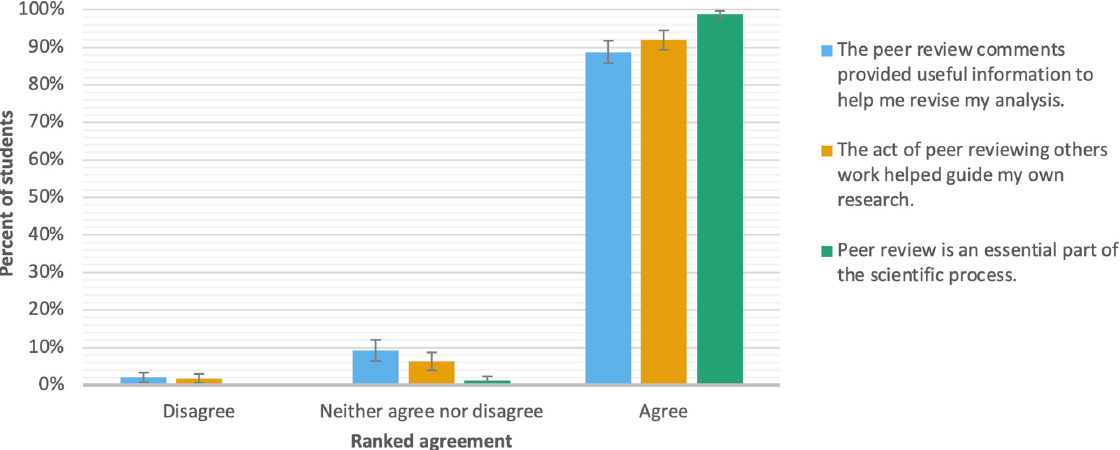
FIG. 6. Students ranked agreement with statements about peer review following their own peer reviews and their corrections based on the reviews. Students responded to a 5-point Likert scale from strongly disagree to strongly agree. The responses presented in the graph have been collapsed to a 3-point scale. The uncertainty was calculated using the 95% binomial confidence interval with n ¼ 398